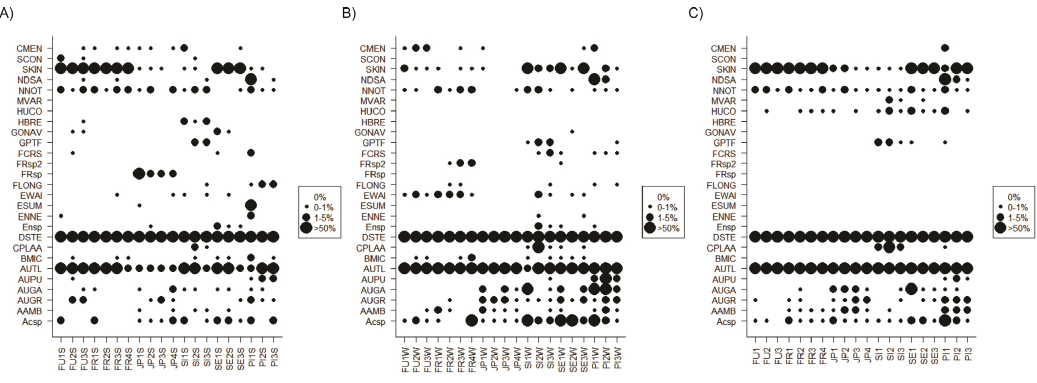
Figure 2. Distribution in samples and relative abundance of diatoms (coded according to OMNIDIA) from Cachoeira da Fumaça (FU), Cachoeira do França (FR), Jurupará (JP), Salto do Iporanga (SI), Serraria (SE) and Paineiras (PI) reservoirs. (A) Phytoplankton (summer), (B) Phytoplankton (winter) and (C) Surface Sediment. The numbers refer to the sampling